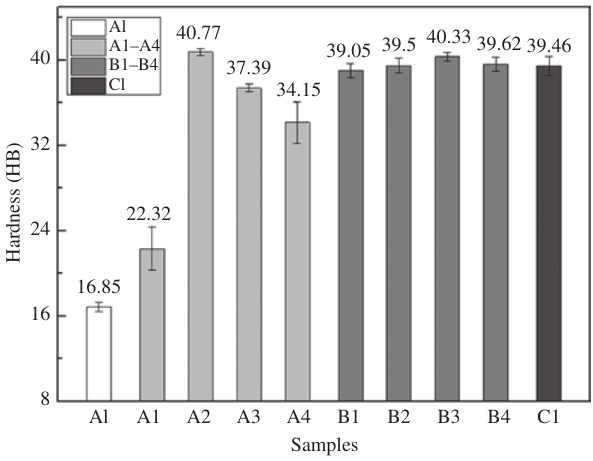
Figure 6: The Brinell hardness of all the